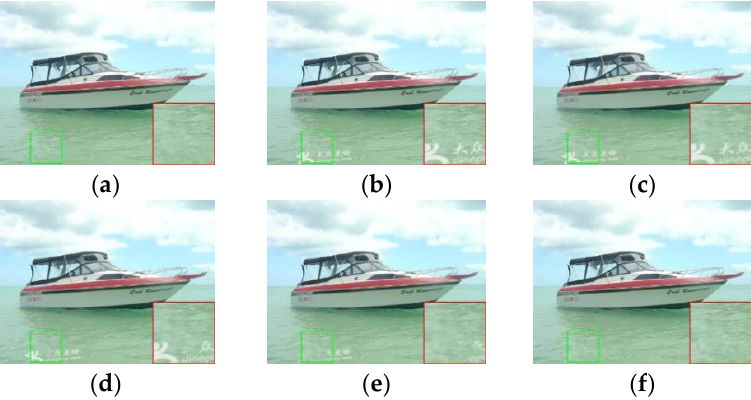
Figure 5. Visual effects of different methods with a transparency rate of 0.7 for image watermark removal. ( a ) Original image, ( b ) watermark image, ( c ) DnCNN, ( d ) FFDNet, ( e ) U-net and ( f ) IWRU-net (ours).